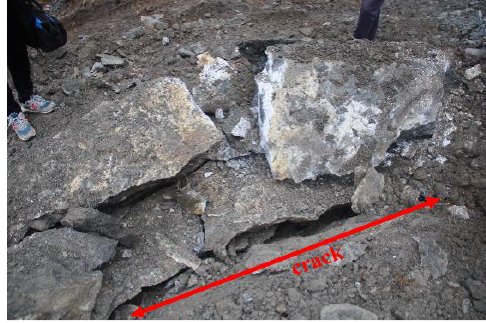
Figure 5. Rock breaking effect of carbon dioxide phase transition fracturing.